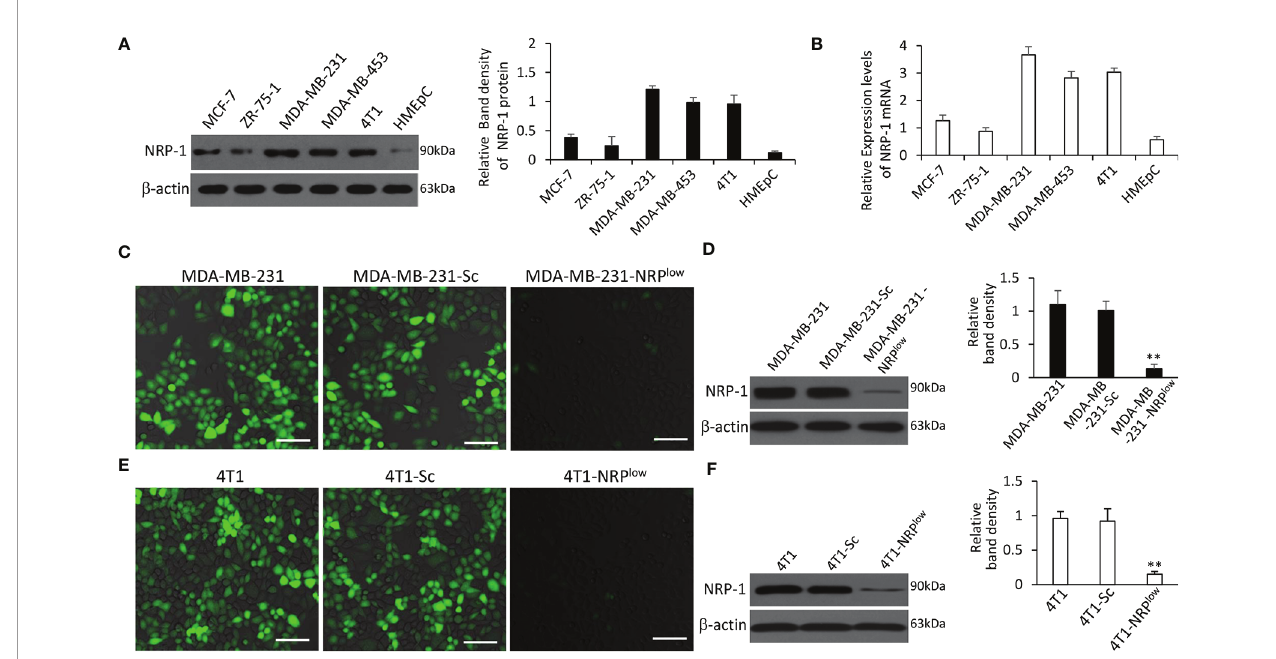
FIGURE 1 | Expression of NRP-1 in breast cancer cells and validation of stable transfectants. (A, B) A panel of cell lines were lysed and subjected to Western blot analysis for detecting expression of NRP-1 protein (A) and qRT-PCR for measuring the expression of NRP-1 mRNA (B) . (C – F) MDA-MB-231 and 4T1 cells were genetically modi fi ed to generate stably transfected MDA-MB-231-Sc, MDA-MB-231-NRP low , 4T1-Sc and 4T1-NRP low cells, respectively. NRP-1 expression (stained green) in the above cells was examined by fl uorescent immunocytochemistry (C, E) and Western blot analysis (D, F) with an anti-NRP-1 Ab. Scale bar, 50 m m. Band density was normalized to b -actin. “ ** P<0.001 ” (one-way ANOVA with a Tukey post-hoc test) indicates a signi fi cant downregulation from corresponding parental